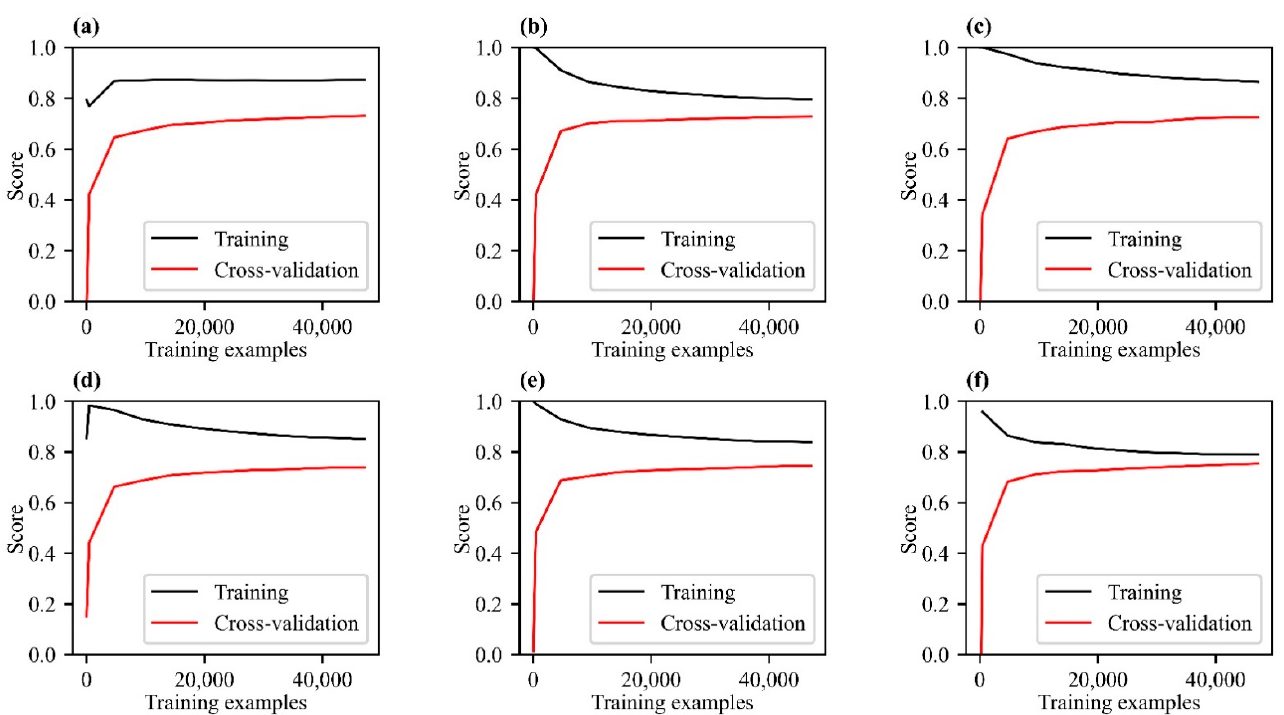
Figure 7. Learning curves of the six models for different training set sizes. ( a ) RF, ( b ) GB, ( c ) XGB, ( d ) LGBM, ( e ) CatBoost, and ( f ) Stacked.